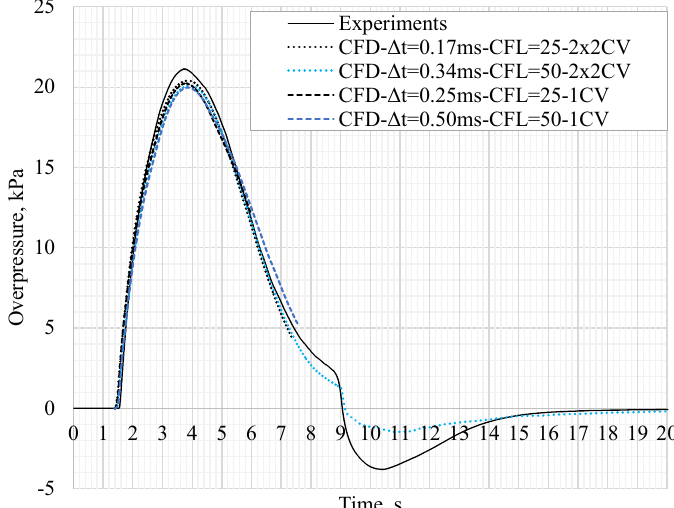
Figure 3. Simulated pressure dynamics in the enclosure with inflow boundary conditions at the notional nozzle exit for different CFL number and nozzle grid refinement (CVs) versus experimental pressure transient for Test No.14 ( P S = 11.78 MPa, 𝑚 (cid:4662) = 11.37 g/s, Number of simulated experimental vents = 3).